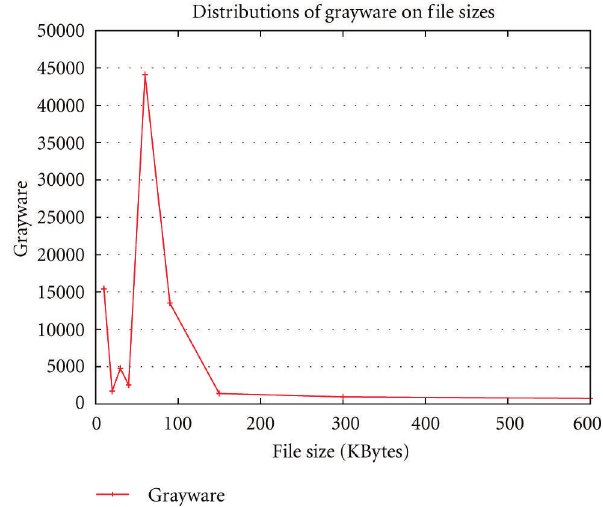
Figure 21: Grayware population with various file sizes.